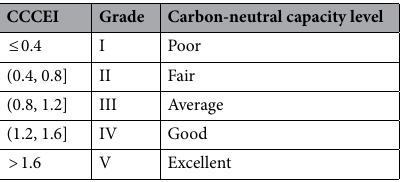
Table 2. Classification of carbon-neutral capacities in the Yellow River basin.